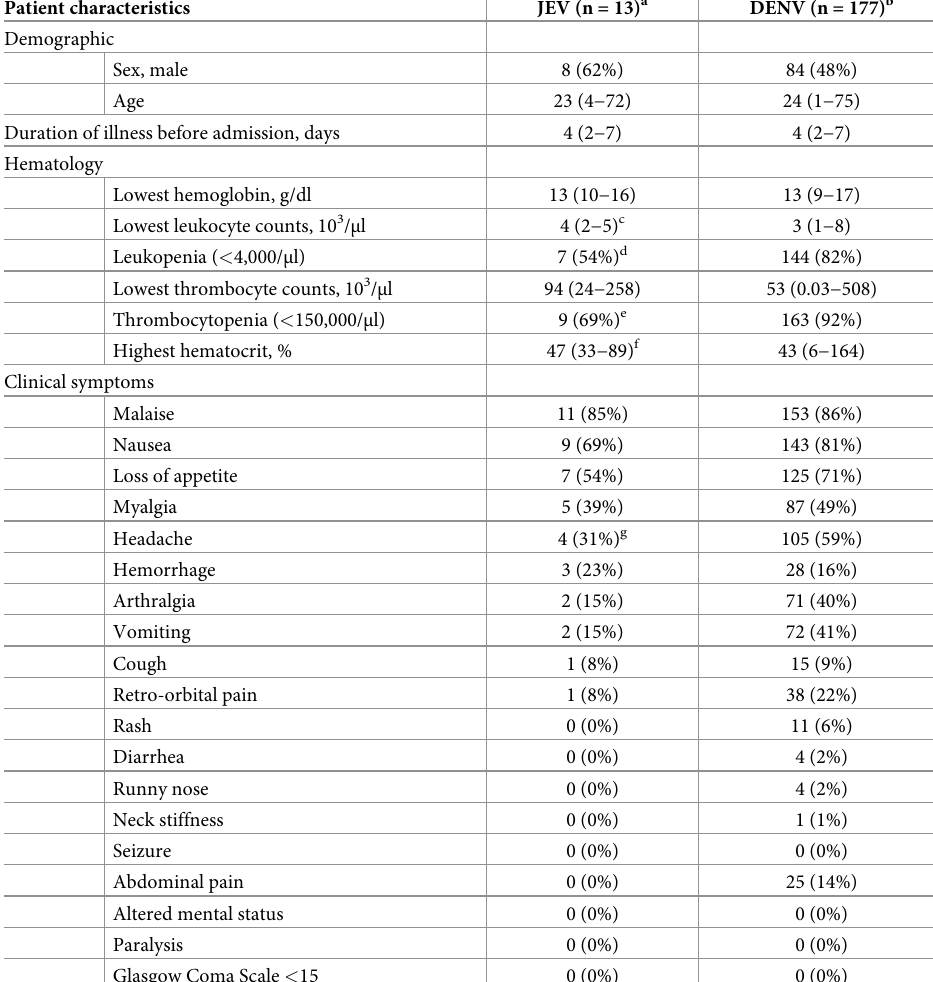
Table 3. Characteristics of patients with JEV and DENV infection identified in this study. Patient